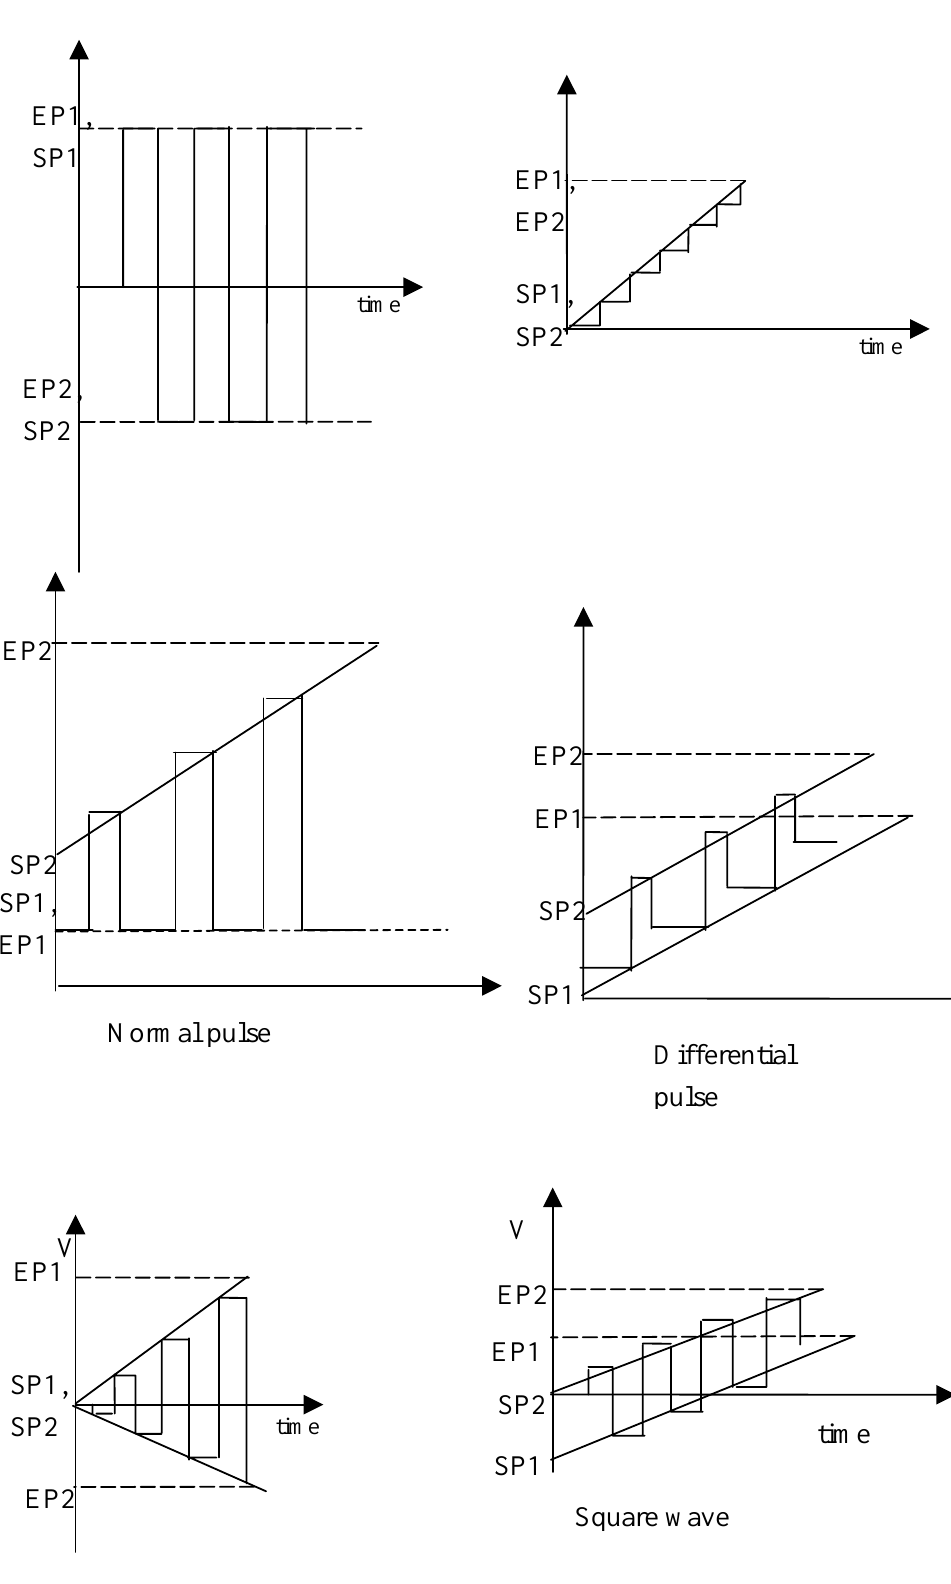
Figure 6. Diagrams showing how different waveforms are generated by the PIC microcontroller for the pulsed voltammetry